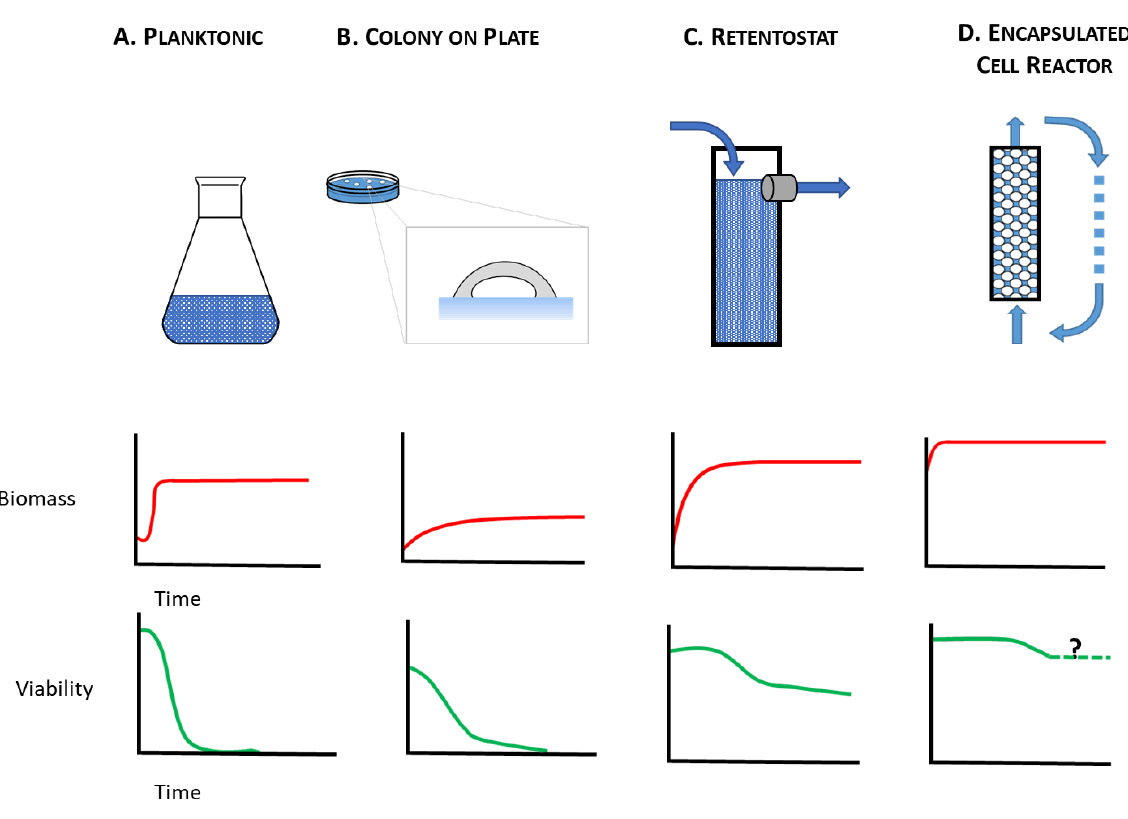
FIGURE 1: Chronological lifespan of non-dividing yeast has been studied using multiple culture methods. (A) planktonic cultures, (B) colo- nies on plates, (C) retentostats, and (D) encapsulated cell reactors, each of which presents a different time-dependent profile of biomass accumulation and cell